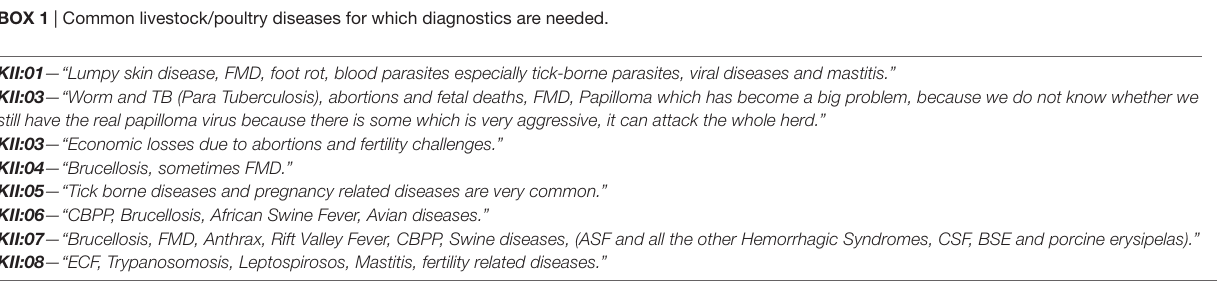
BOX 1 | Common livestock/poultry diseases for which diagnostics are